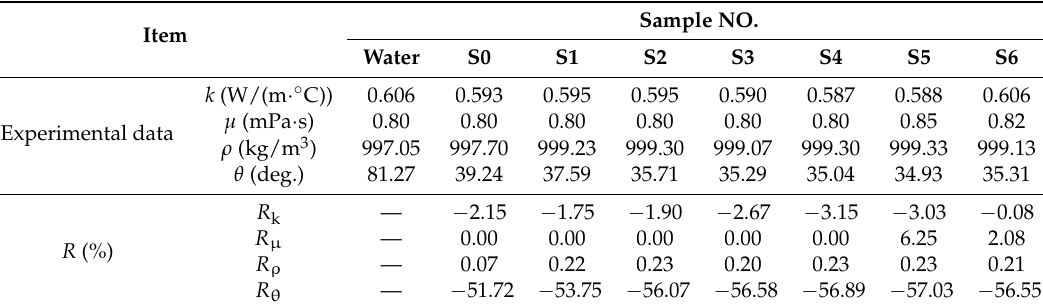
Table 2. Results for fundamental characteristics.